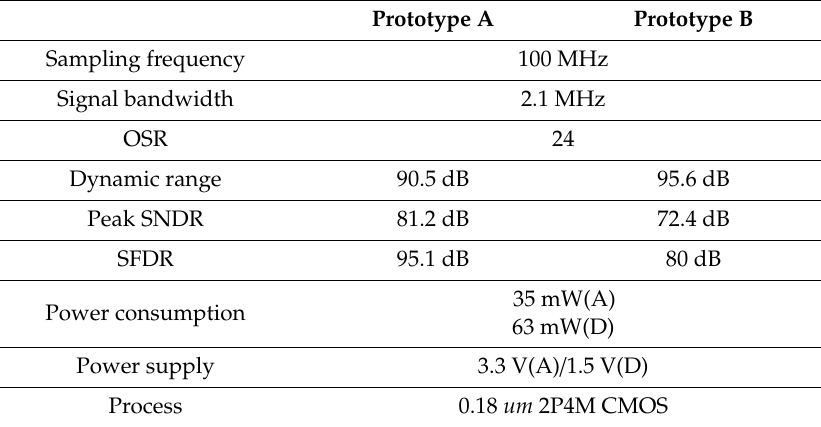
Table 1. Performance